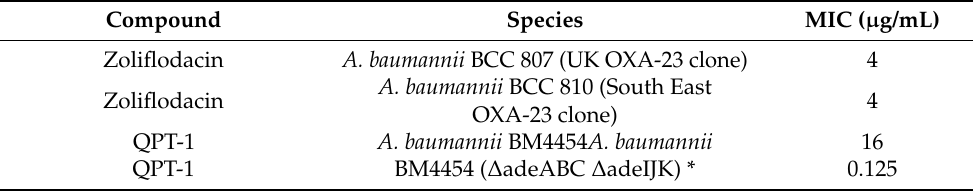
Table 1. MICs of zoliflodacin for A. baumannii